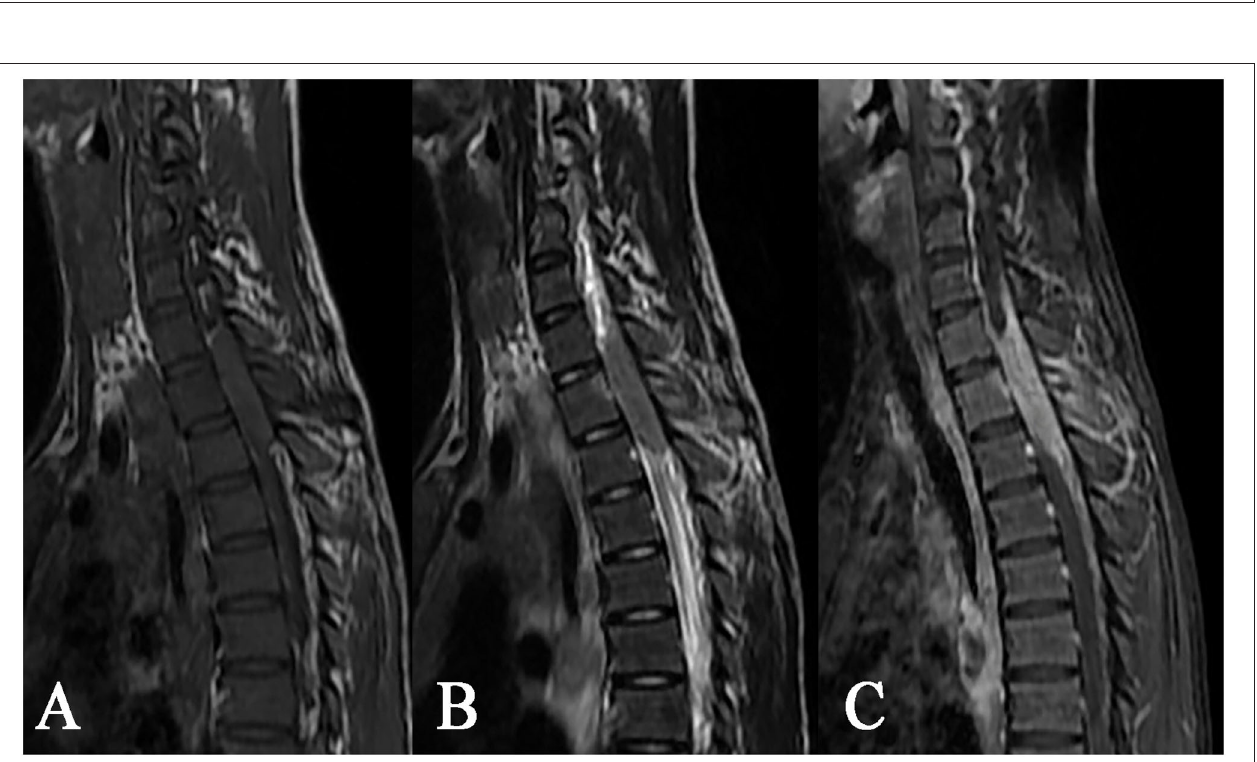
FIGURE 3 | Intradural extramedullary tuberculoma of thoracolumbar spinal cord. A lesion having a longitudinal long-fusiform shape: (A) isointense on T1WI, (B) hyperintense on T2WI, and (C) apparent heterogeneous enhancement after contrast enhancement, showing a narrowed adjacent spinal cord due to compression.